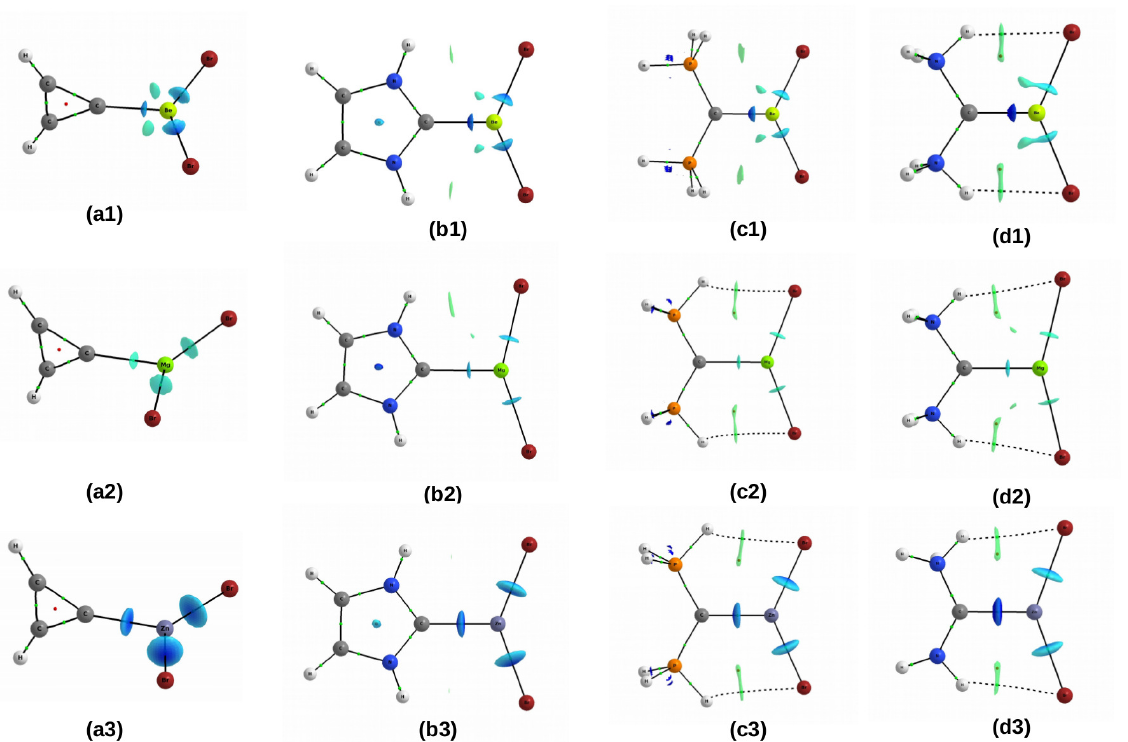
Figure 16. Reduced gradient density isosurfaces ( s = 0.3 au) for dimers involving ( a ) cyclopropenylidene, ( b ) imidazol-2- ylidene, ( c ) (PH 3 ) 2 C, ( d ) (NH 3 ) 2 C and ( 1 ) BeBr 2 , ( 2 ) MgBr 2 , ( 3 ) ZnBr 2 . Colors are coded according to a common electron density scale (in au): 0.00—green, 0.05—cyan, 0.10—blue. A cutoff of 0.12 au was used for the electron